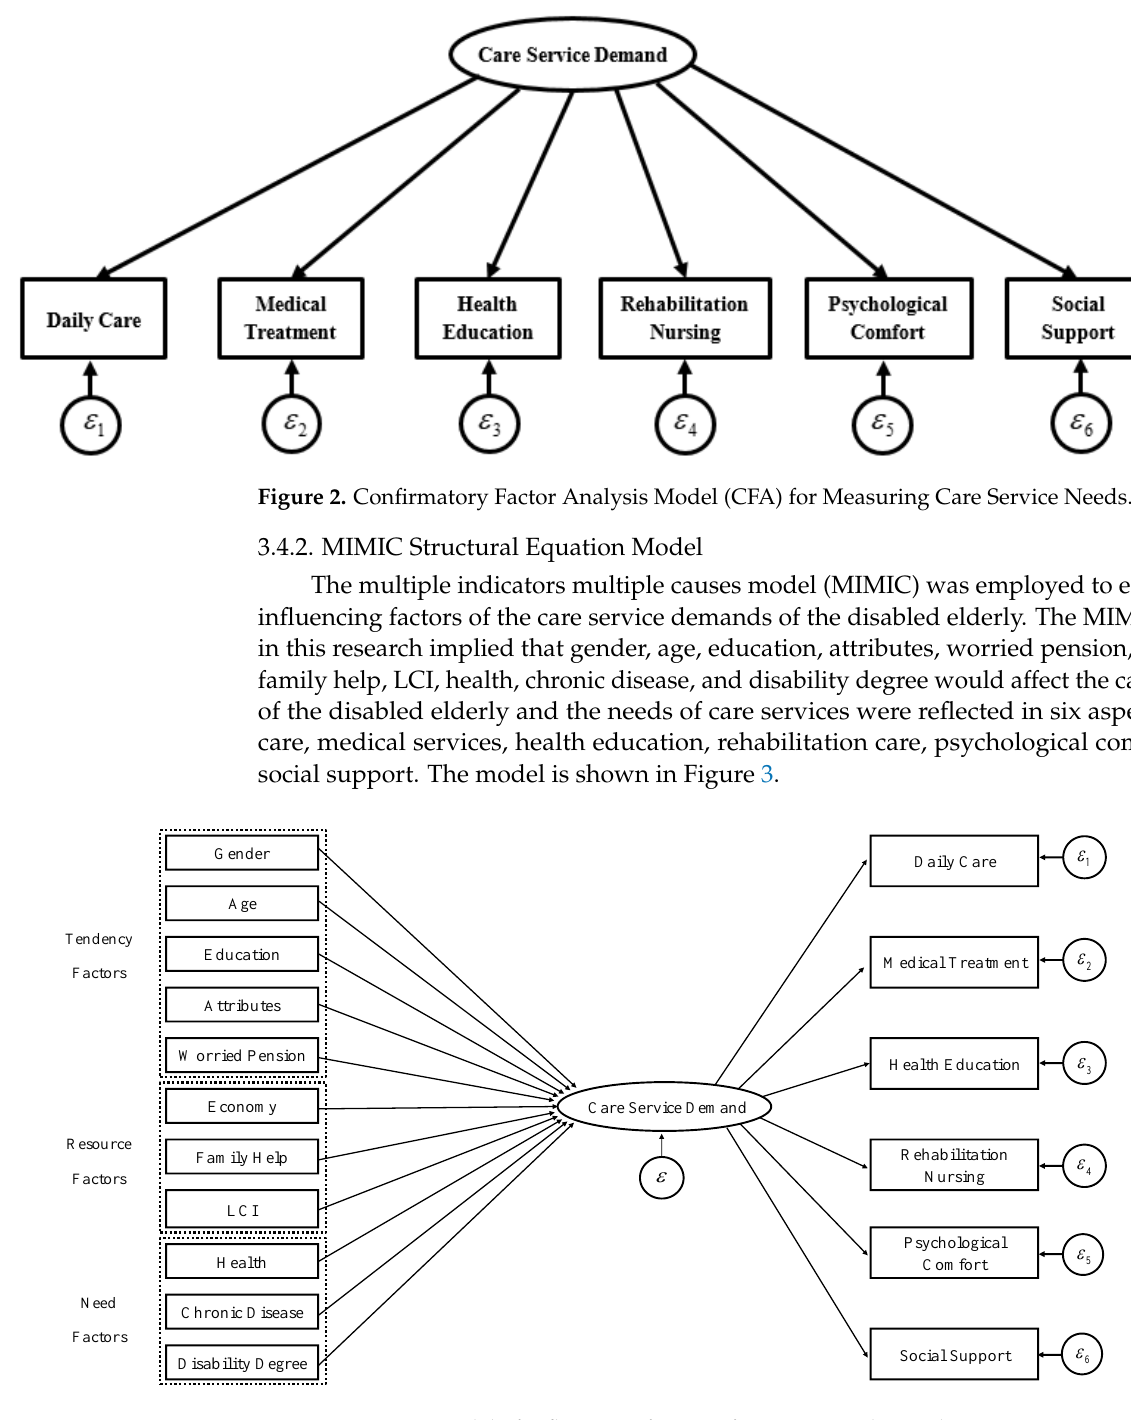
Figure 3. MIMIC model of influencing factors of care service demand.